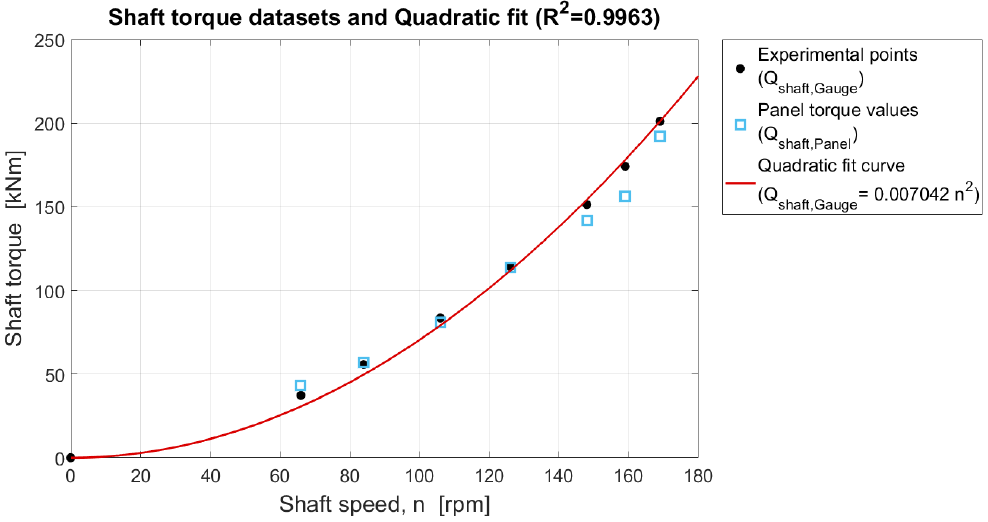
Figure 11. Shaft torque values ( Q shaft,Gauge and Q shaft,Panel ) and fit curve of Q shaft,Gauge ( n )